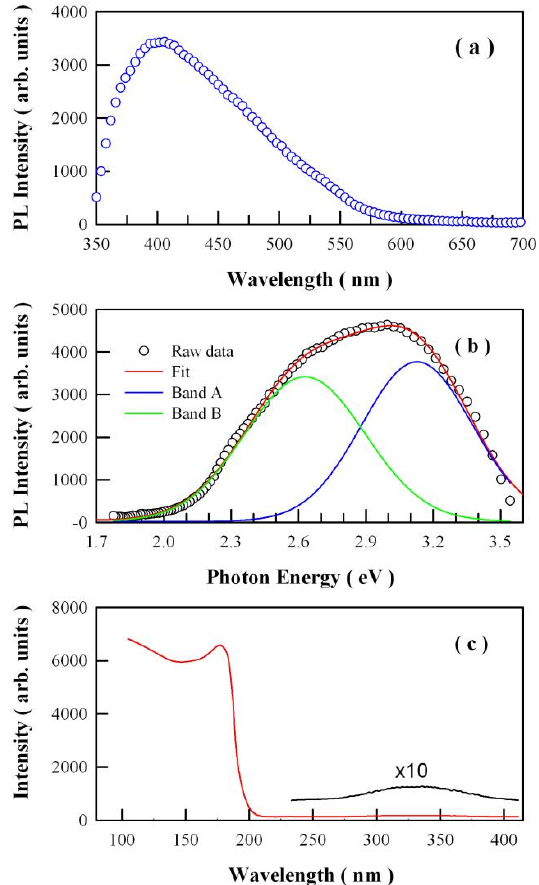
Figure 4. ( a ) Steady-state PL spectrum of undoped SrAl 2 O 4 in wavelength scale; ( b ) Steady-state PL spectrum of undoped SrAl 2 O 4 in energy scale; and ( c ) Ultraviolet–vacuum ultraviolet synchrotron radiation excitation spectrum of undoped SrAl 2 O 4 at room temperature. The emission wavelength is 520 nm.